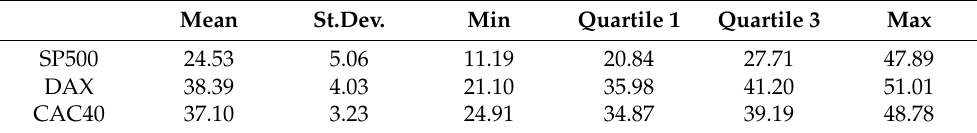
Figure 3. Time-varying covariance capital allocations. Table 2. Descriptive statistics for dynamic allocation principle over the entire